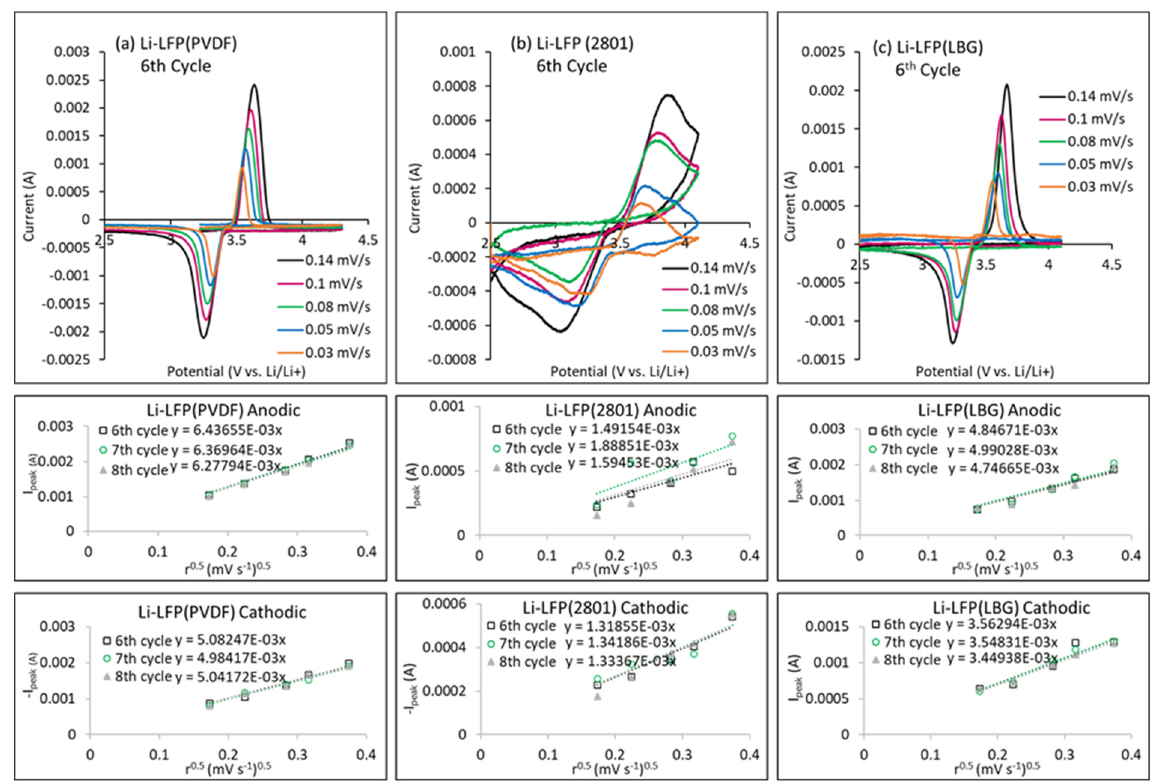
Figure 9. CV plots from CV cycling of Li-LFP battery cells and the linear fits of the Rendles-Shevchik equation for determining the Li + ion diffusion coefficient in cathode. Cathodes: ( a ) PVDF binder; ( b ) KynarFlex ® PVDF 2801-00 binder; ( c ) Kynar PowerFlex ® LBG binder. The CV results for the Li-LFP half cell with cathode binder KynarFlex ® PVDF 2801-